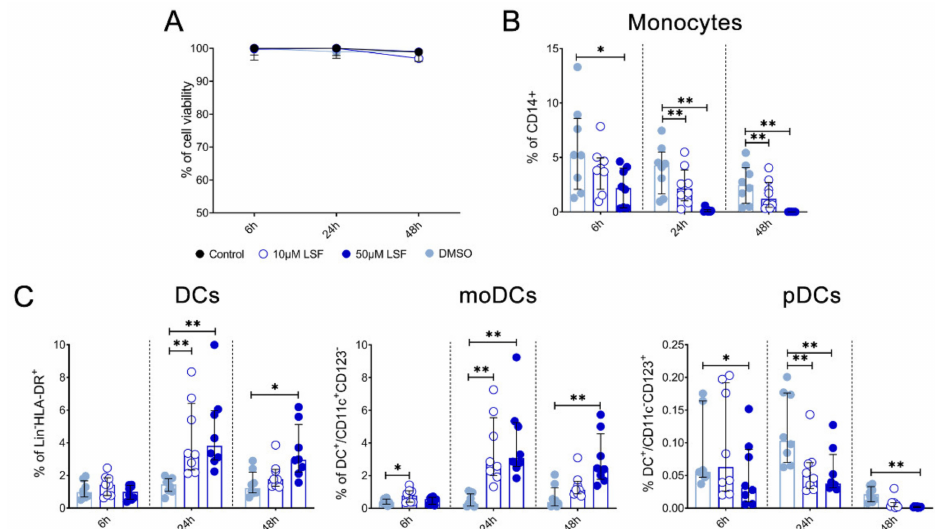
Figure 4. LSF effect on monocyte and dendritic cell populations. The effect of 10 µ M or 50 µ M LSF on DC populations in healthy adult PBMCs ( n = 8) over 6, 24, or 48 h. PBMC viability ( n = 8) ( A ) and flow cytometric results of monocytes ( B ) and DC subsets ( C ) displayed as a proportion of total lymphocyte populations, with the median ± IQR displayed. DMSO was used as a vehicle control for LSF treatments. * p < 0.05, ** p < 0.01 compared to the untreated DMSO control using a non-parametric Wilcoxon signed-rank test. Legend: • Control, 10 µ M LSF, • 50 µ M LSF, • DMSO. Abbreviation: CD, cluster of differentiation; DC, dendritic cell, DMSO, dimethyl sulfoxide; HLA-DR, Human Leukocyte Antigen – DR isotype; IQR, inter-quartile range; Lin, lineage; LPS, lipopolysaccharide; LSF, L-sulforaphane; moDC, monocyte-derived dendritic